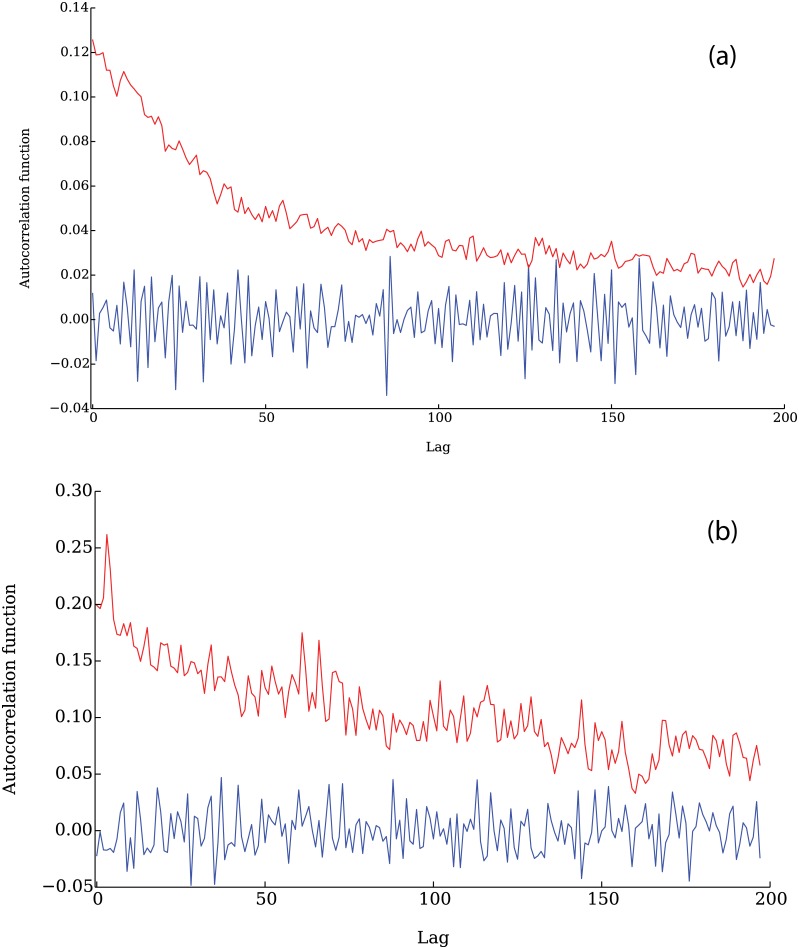
Returns auto-correlation function for the simulation (a) and comparison with empirical data from Airgas Inc (b).While the auto-correlation of the direct returns (blue lines) is zero, the auto-correlation of the absolute value of the returns (red lines) remains positive for a long period of time, and decays slowly to zero. Data obtained from QuantQuote [43].